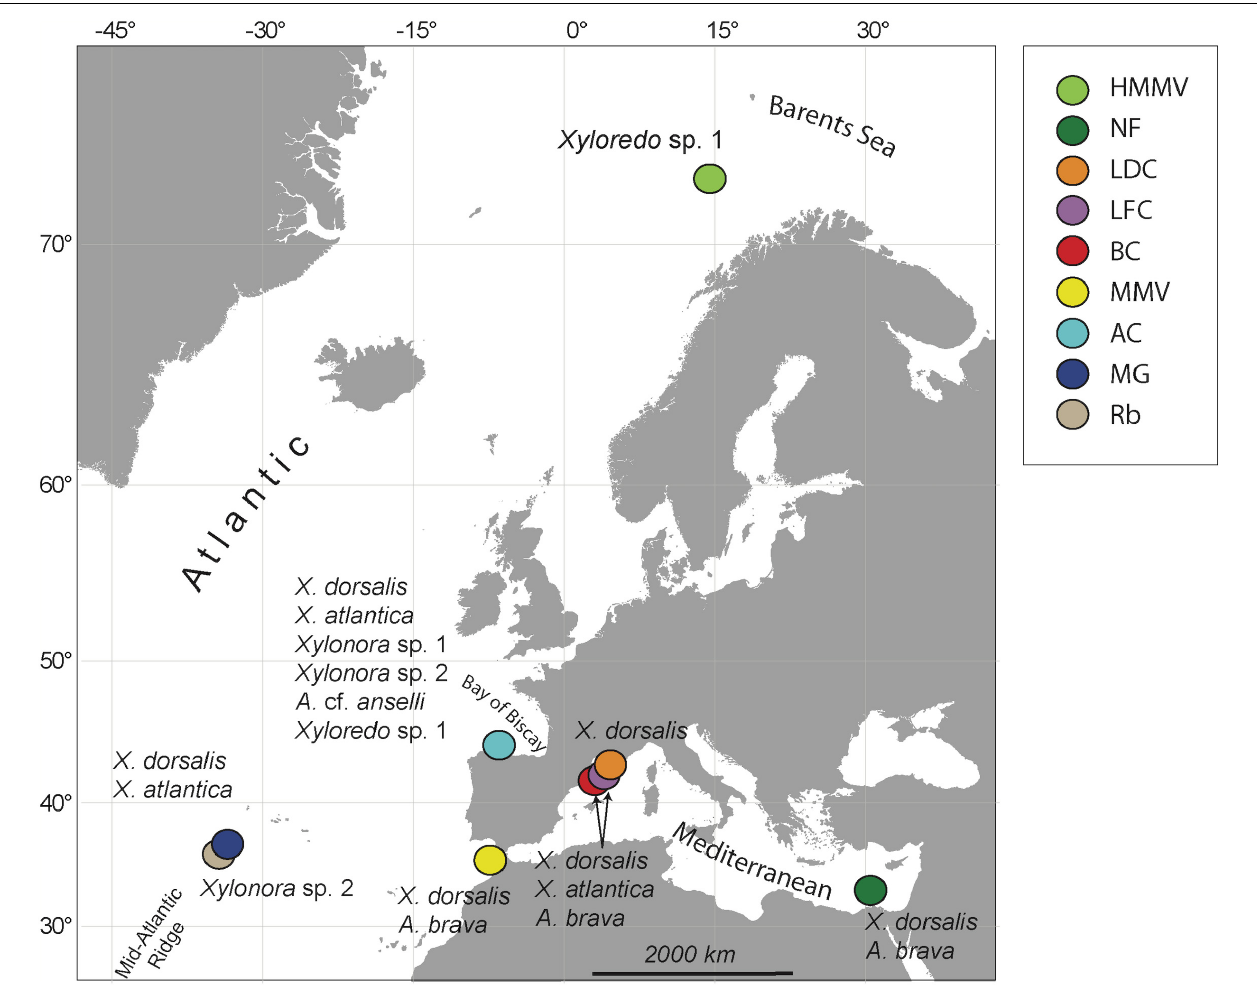
FIGURE 1 | Sites of experimental wood deployments. HMMV, Haakon Mosby mud volcano; NF, Nile Fan; LDC, Lacaze-Duthiers Canyon; LFC, La Fonera Canyon; BC, Blanes Canyon; MMV, Morocco mud volcanoes, including Mercator and Meknès mud volcanoes; AC, Avilés Canyon; RB, Rainbow; and MG, Menez Gwen hydrothermal vent fields on the Mid-Atlantic Ridge. Recovered species of Xylophagaidae are shown close to each site.